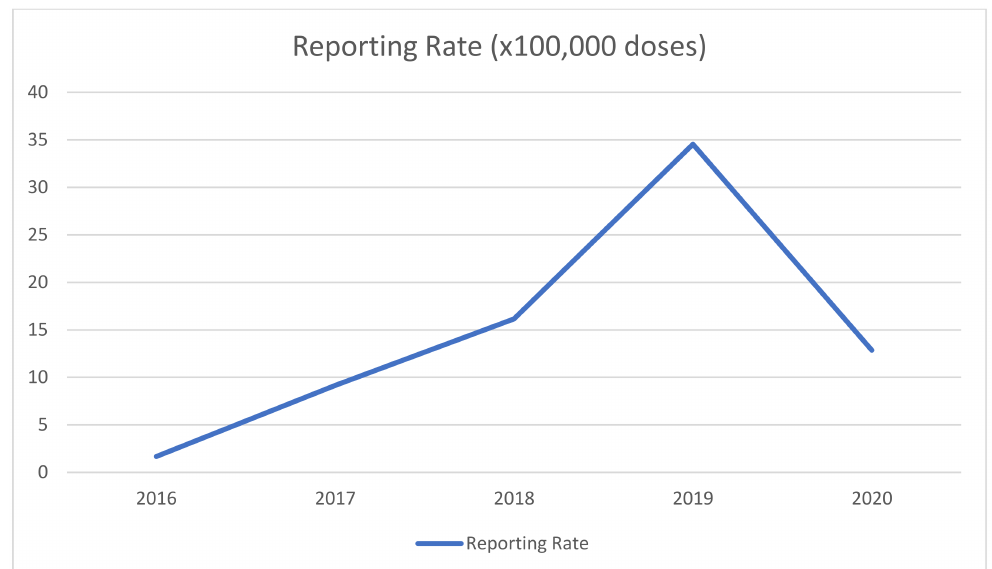
Figure 1. AEFIs reporting rates during